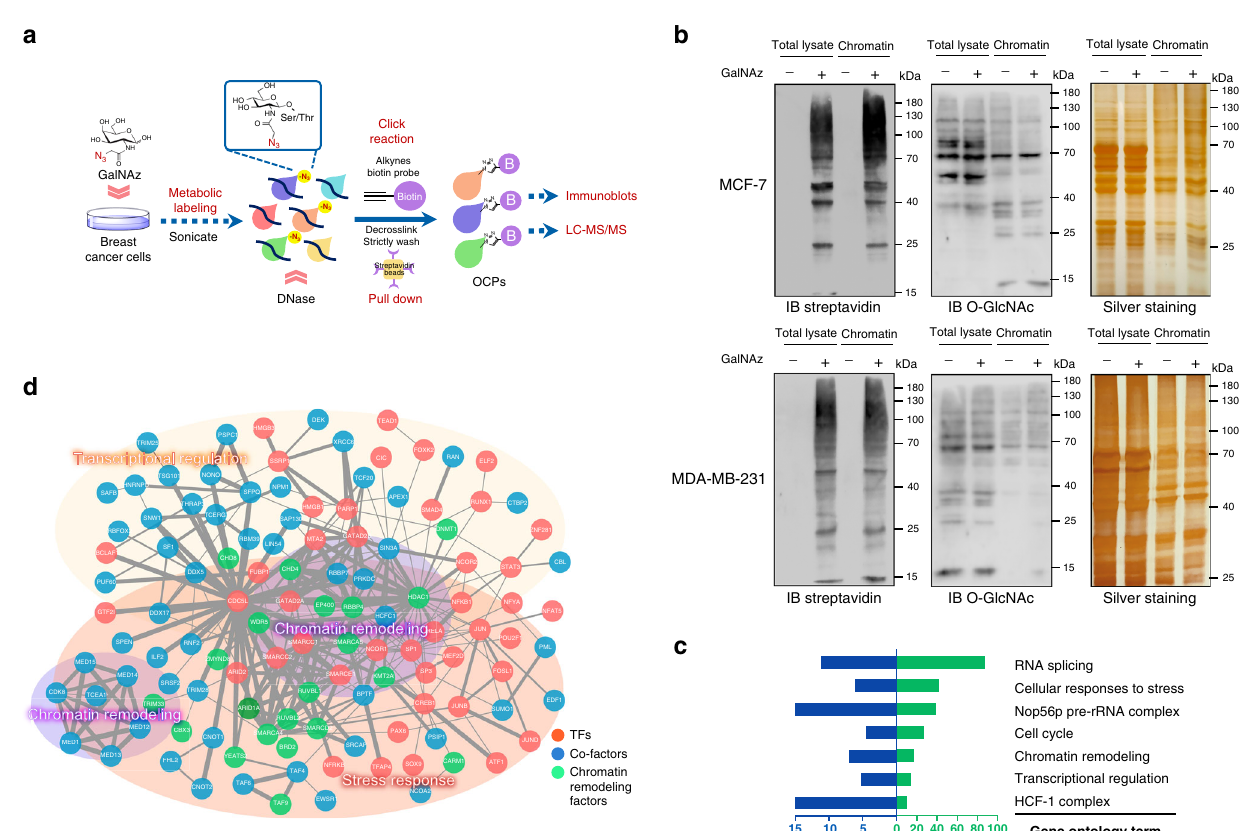
Fig. 1 OCPs are related to the stress response and transcriptional regulation. a Chemical reporter-based metabolic labeling method used to analyze the OCPs by immunoblotting and LC-MS/MS. MCF-7 and MDA-MB-231 cells were incubated in 1 mM GalNAz media or vehicle for 24 h. Azide (N 3 ) is shown in bold in the chemical structure. Biotin-alkynes (B) was used. Chromatin was crosslinked and conjugated to alkyne-biotin by a downstream click reaction. O-GlcNAz chromatin was subsequently decrosslinked and enriched with streptavidin-beads for immunoblotting and LC-MS/MS. b Immunoblotting and silver staining of GalNAz labeled MCF-7 and MDA-MB-231 cell lysates and chromatin. Chromatin proteins of cancer cells in the presence and absence (vehicle) of GalNAz (24 h) were extracted and reacted with alkyne-biotin, and subjected to immunoblotting with streptavidin and the O-GlcNAc-speci fi c antibody CTD110.6. All blots and sliver staining are representative of at least two biologically independent experiments. c GO terms enriched for OCPs in MCF-7 cells. d STRING PPI analysis and functional enrichment analysis of OCTFs in MCF-7 cells. b , c Source Data are provided as a Source Data fi